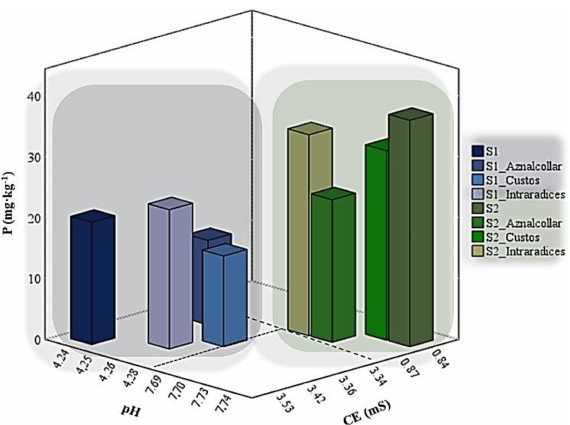
Figure 1. pH, electrical conductivity, and P concentrations in soils 1 (S1) and 2 (S2) inoculated with the three AMF selected (Aznalcollar, Intraradices, and